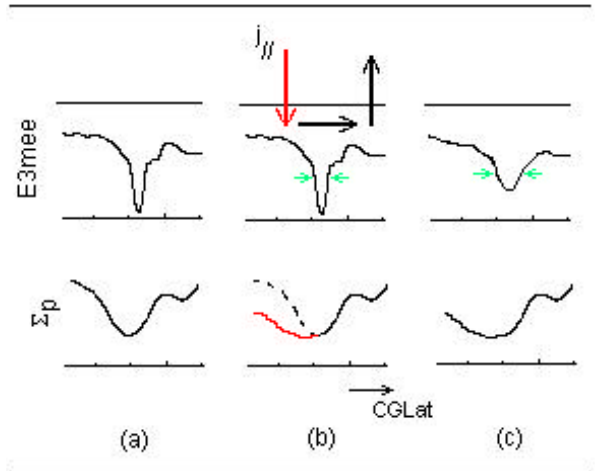
Fig. 11. Schematic picture showing modifications of the reduced conductivity region ( 6 p ) and of the location and intensity of the associated SAID electric field peak ( E 3 mee